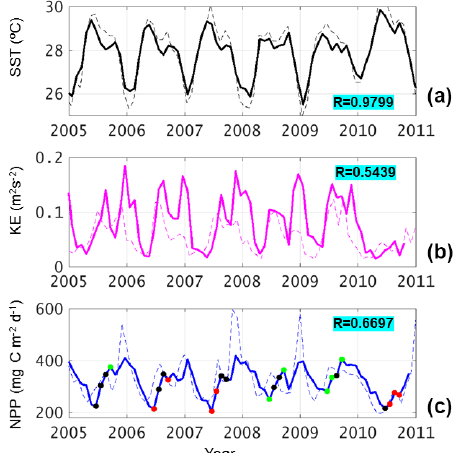
Figure 6. Thick lines: modeled (a) SST in ◦ C, (b) KE in m 2 s − 2 , and (c) NPP in mgCm − 2 day − 1 averaged over the box region (see Fig. 2b), with respective observation data (thin dashed lines). Cor- relation coefficients are also shown in each plot. In panel (c) , green, black, and red dots indicate HNA, normal, and LNA scenarios (see text for